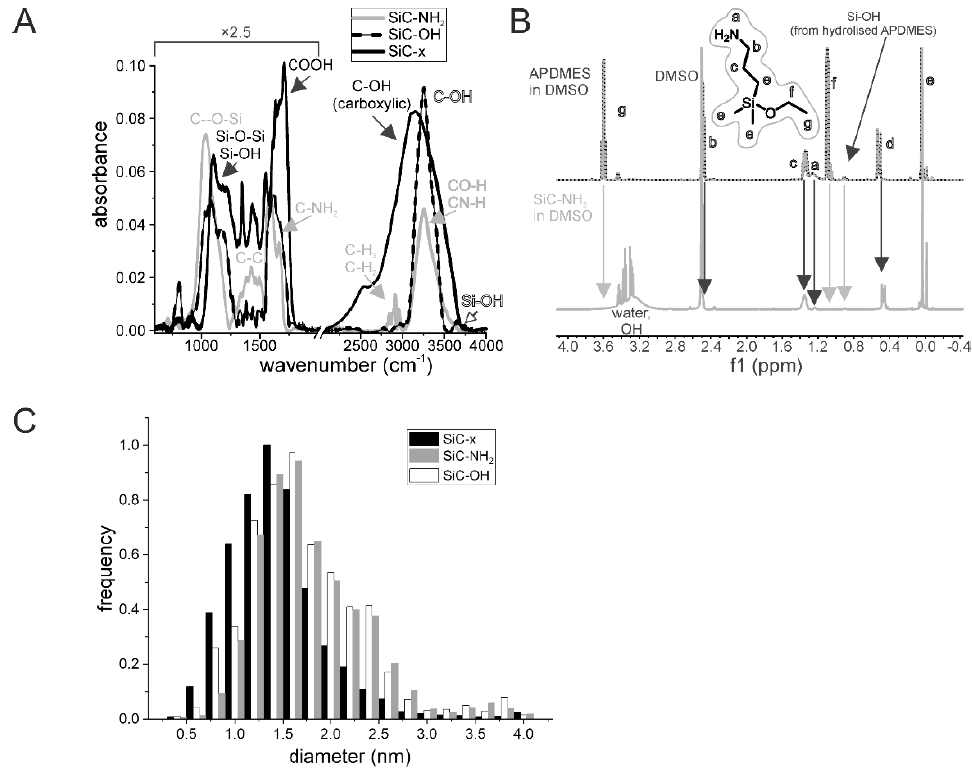
Figure 1. Characterization of the SiC-based NPs. The FTIR spectra ( A ) and size distribution ( B ) of the SiC-based NPs with differing surface terminations based on AFM measurement of individual NPs height. The NMR spectra of APDMES and SiC – NH 2 ( C ).